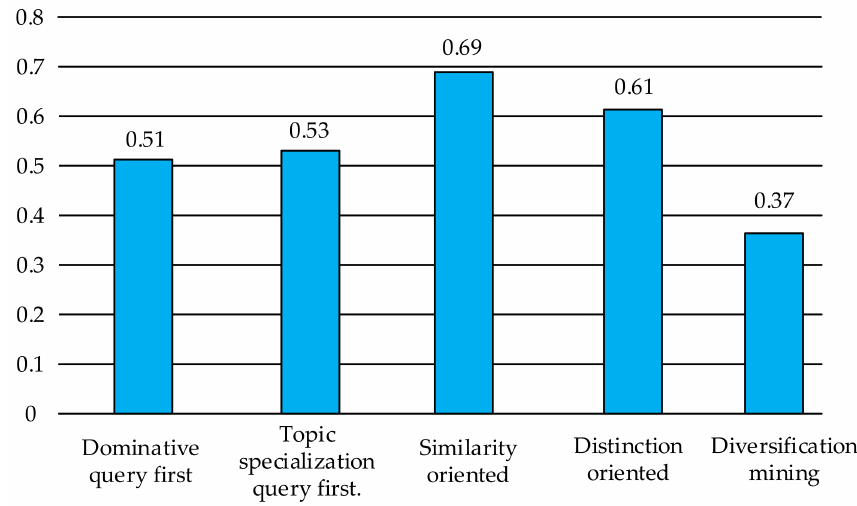
Figure 5. Average semantic distances between all CPQs in every QCB session for each QCB pattern.